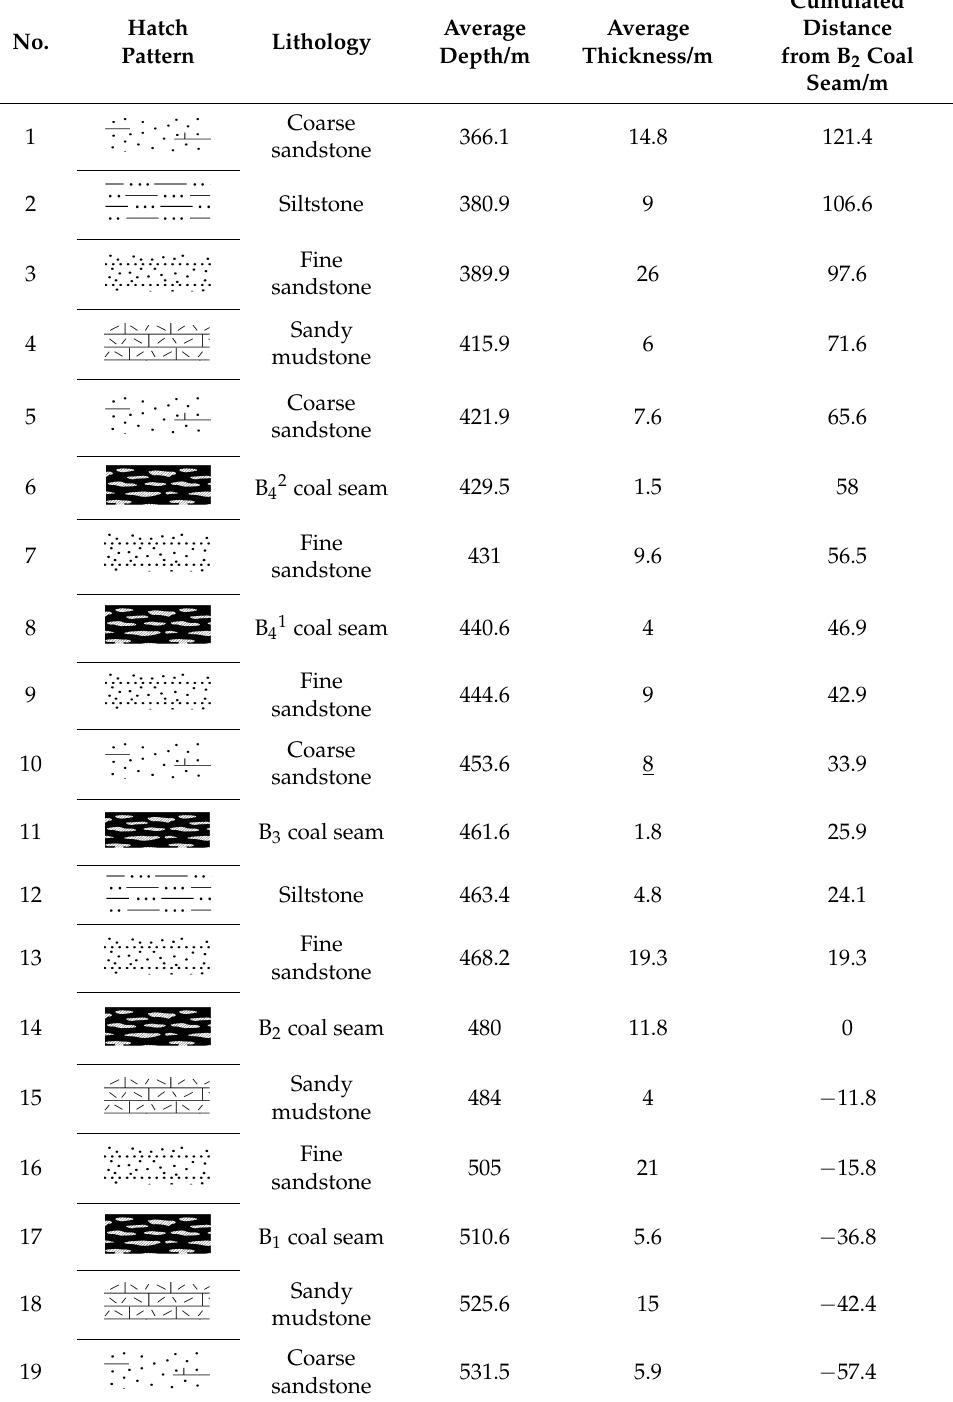
Table 1. Lithological characteristics of the Kuangou coal mine investigated by borehole.